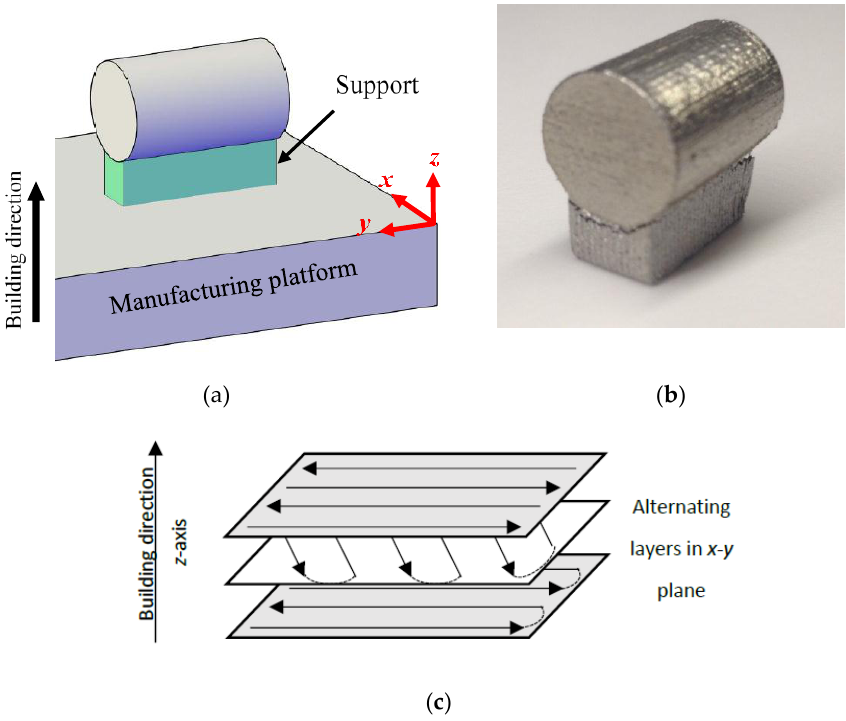
Figure 2. ( a ) Illustration of the cylindrical specimens manufactured in horizontal orientation with respect to the building direction; ( b ) actual printed specimen; ( c ) schematic illustration of the laser scanning strategy used in the current work.